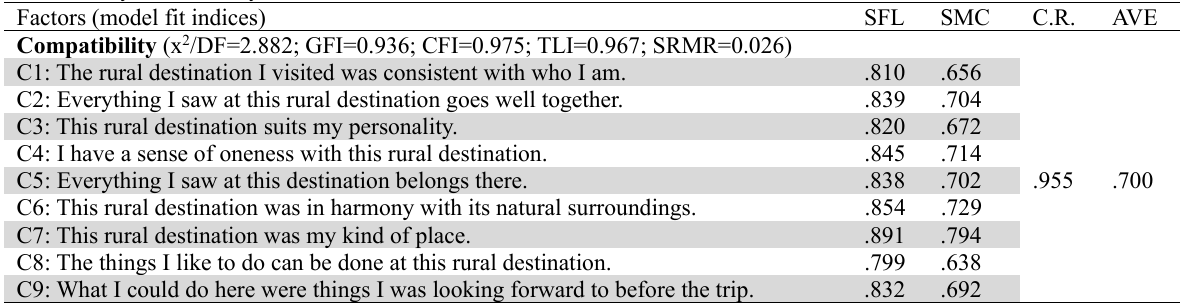
Confirmatory Factor Analysis